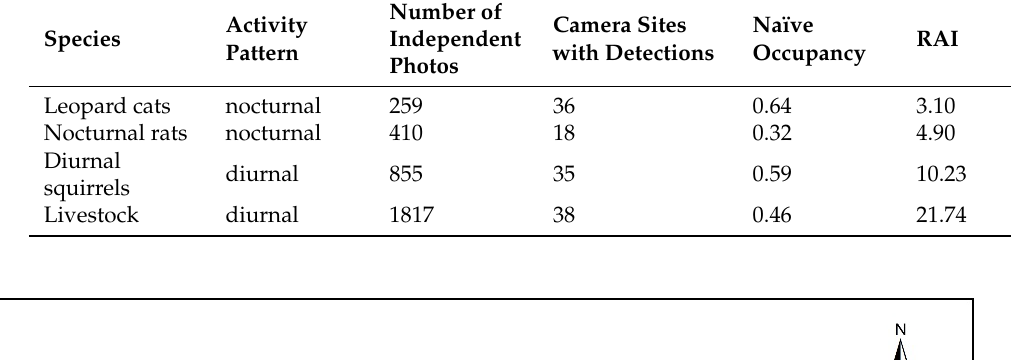
Table 1. Numbers of independent photos and camera sites that recorded leopard cats, their potential prey, and livestock across 56 camera sites, along with their naïve occupancy and RAI.